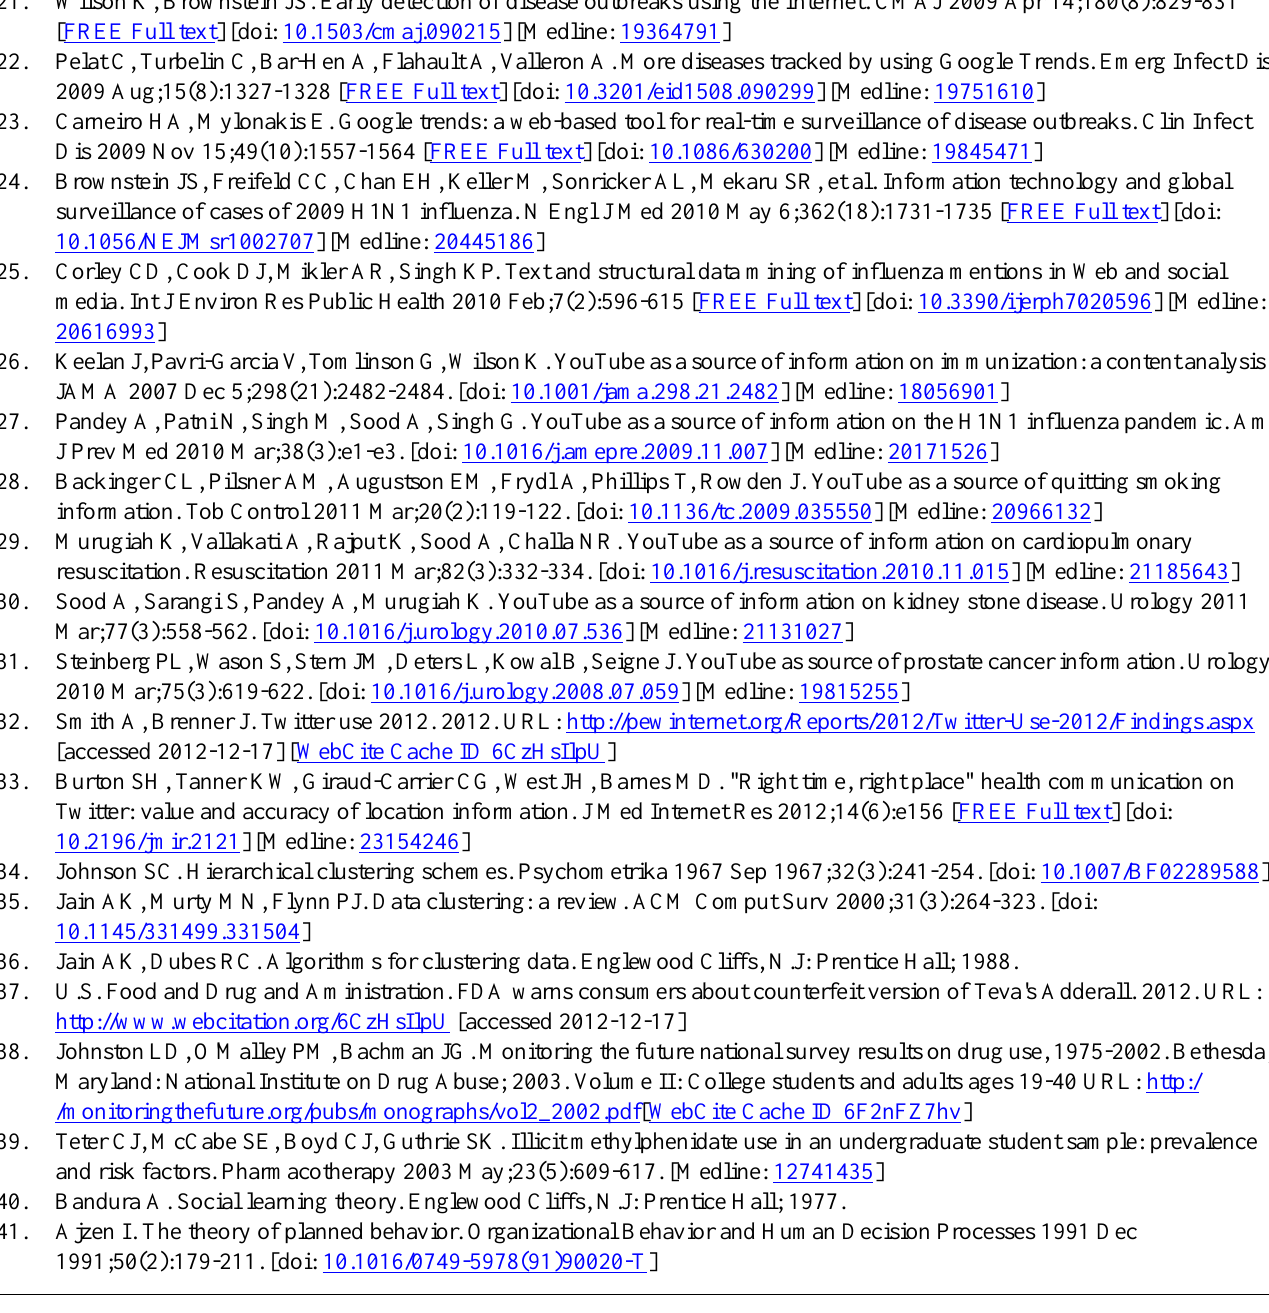
Abbreviations API: Application Programming Interface CDC: Centers for Disease Control and Prevention GPS: Global Positioning System HAC: Hierarchical Agglomerative